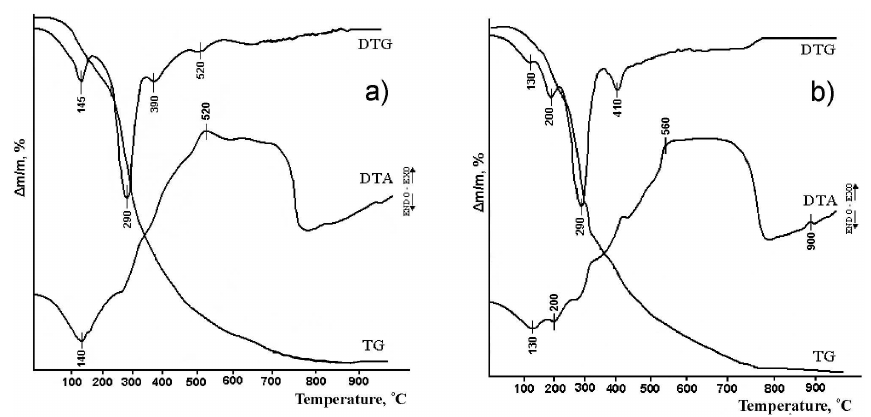
Fig. 5 DTG, DTA and TG curves of Al- (a) and YAl- (b) citric